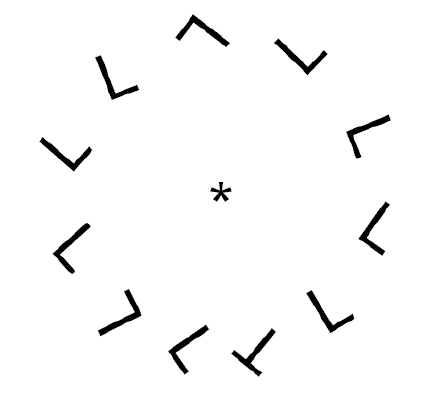
Figure 1. “Example of Parallel Search Pattern”. Source. Own contribution